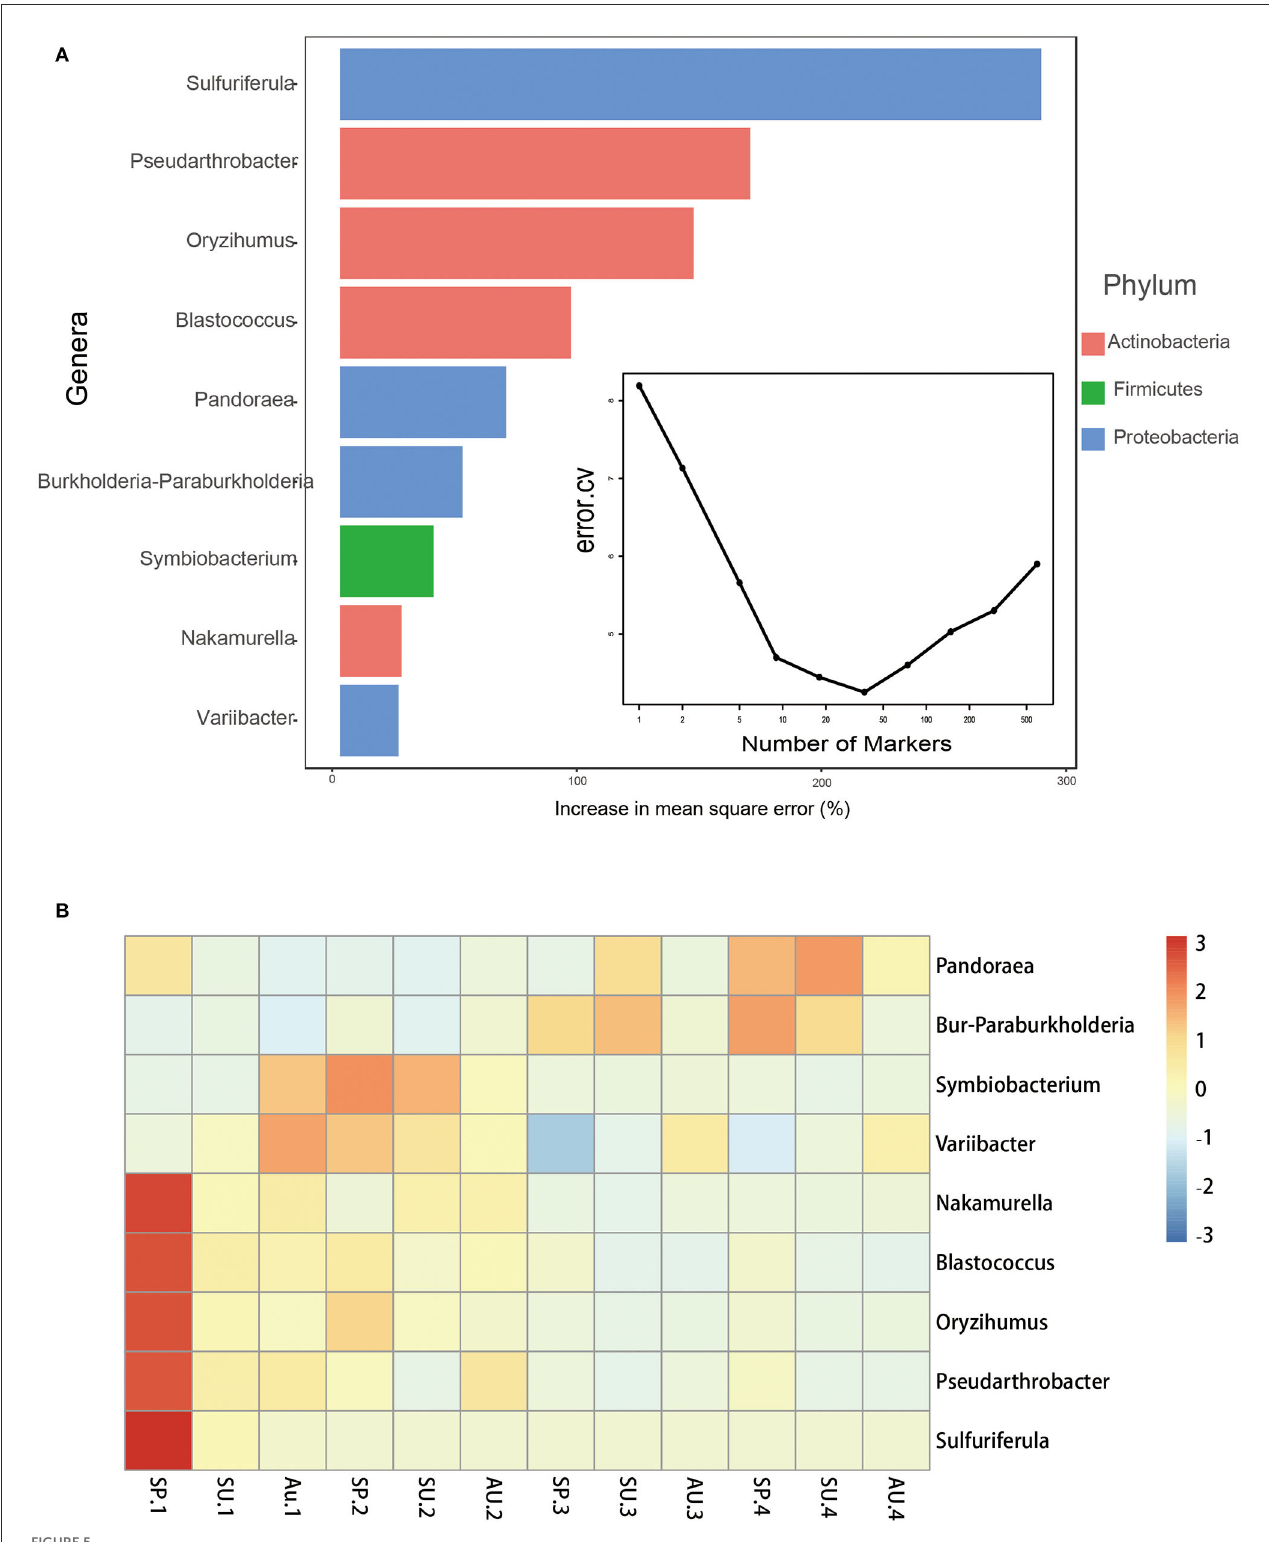
FIGURE5 Bacterial taxonomic biomarkers of American ginseng cultivated time in fields. (A) The top nine biomarker bacterial genera were identified by applying Random Forests regression of their relative abundances in soil against American ginseng years of cultivation and seasons in the field. Biomarker taxa are ranked in descending order of importance to the accuracy of the model. (B) A heat map showing the relative abundances of the top nine predictive biomarker bacterial